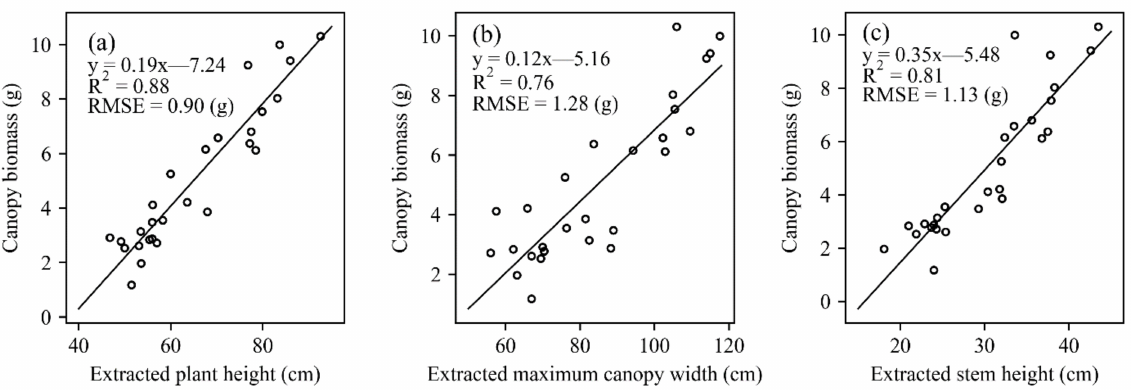
Figure 11. Relationships between plant biomass and the extracted structural proxies of ( a ) plant height, ( b ) maximum canopy width, and ( c ) stem